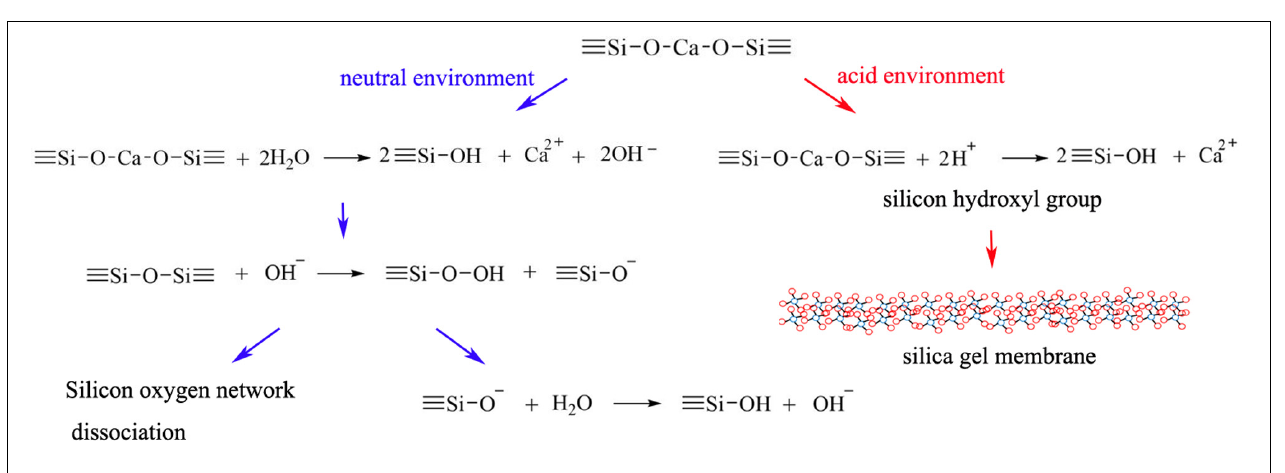
FIGURE 8 | Scheme of the ionic reaction of BG nanoparticles in a neutral or acidic